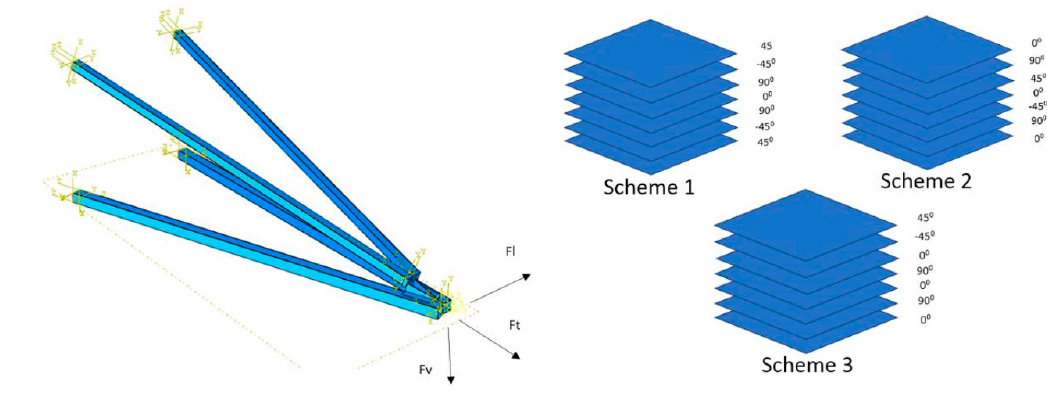
Figure 8. Schematic sequence of fabric layers of composite cross arms [83].